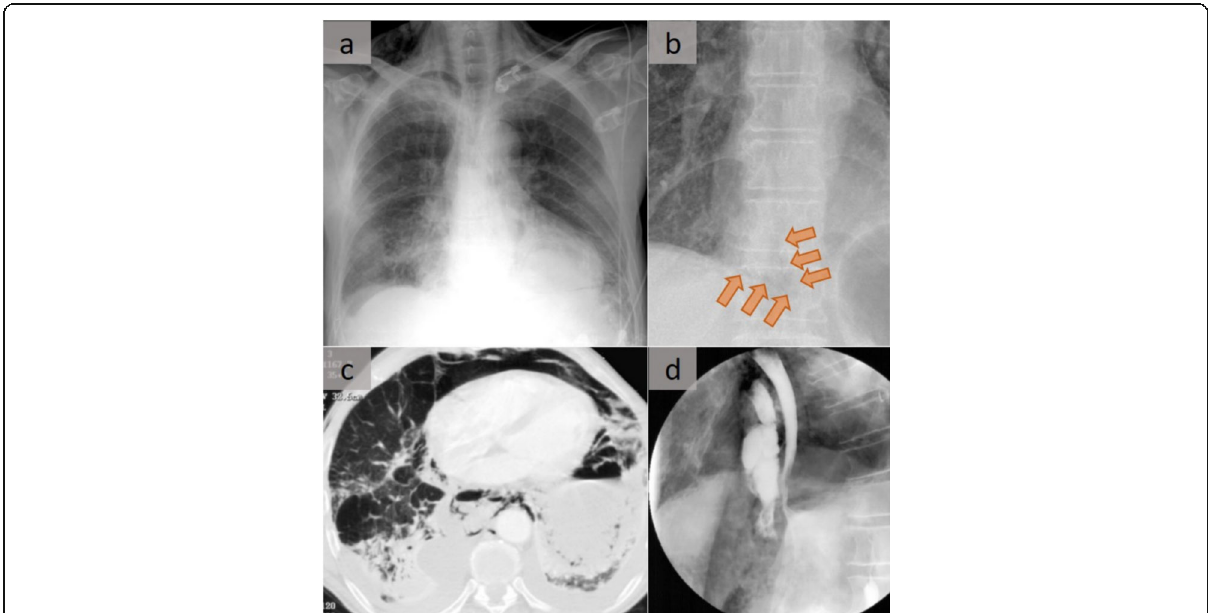
Fig. 4 Boerhaave ’ s syndrome related to esophageal rupture. a Chest X-ray shows pneumomediastinum with subcutaneous emphysema. b Naclerio V sign in another patient. In this case, the Naclerio V sign was the only finding that raised the suspicion of an esophageal rupture (not shown) with a focal and limited pneumomediastinum. c Axial CT scan in lung windowing that shows the pneumomediastinum with bilateral pleural effusion and alveolar consolidation ( d ). Iodine hydro-soluble contrast on a lateral view shows extravasation above the diaphragm in front